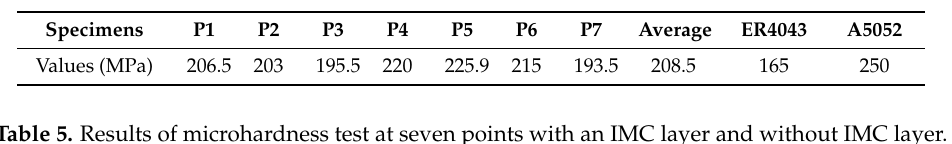
Table 4. Results of tensile test of seven specimens’ welded A5052 aluminum alloys/SS400 steel.